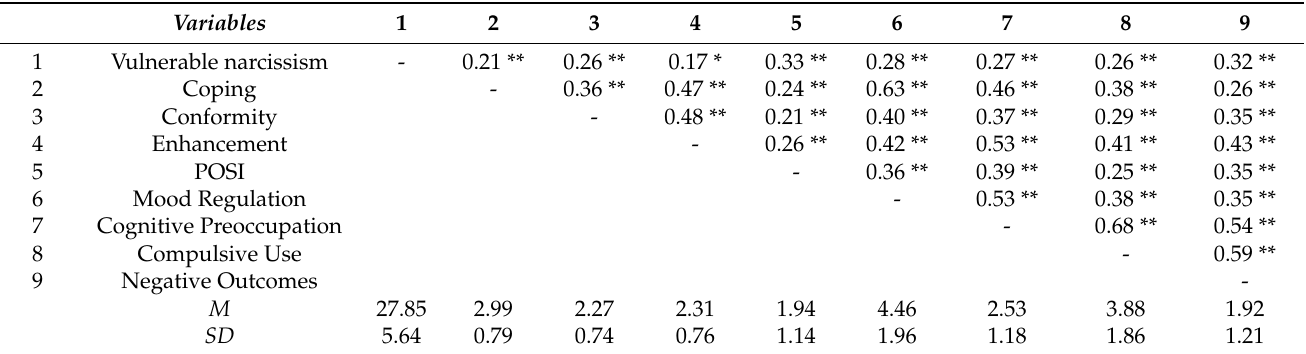
Table 2. Descriptive statistics and intercorrelations for all